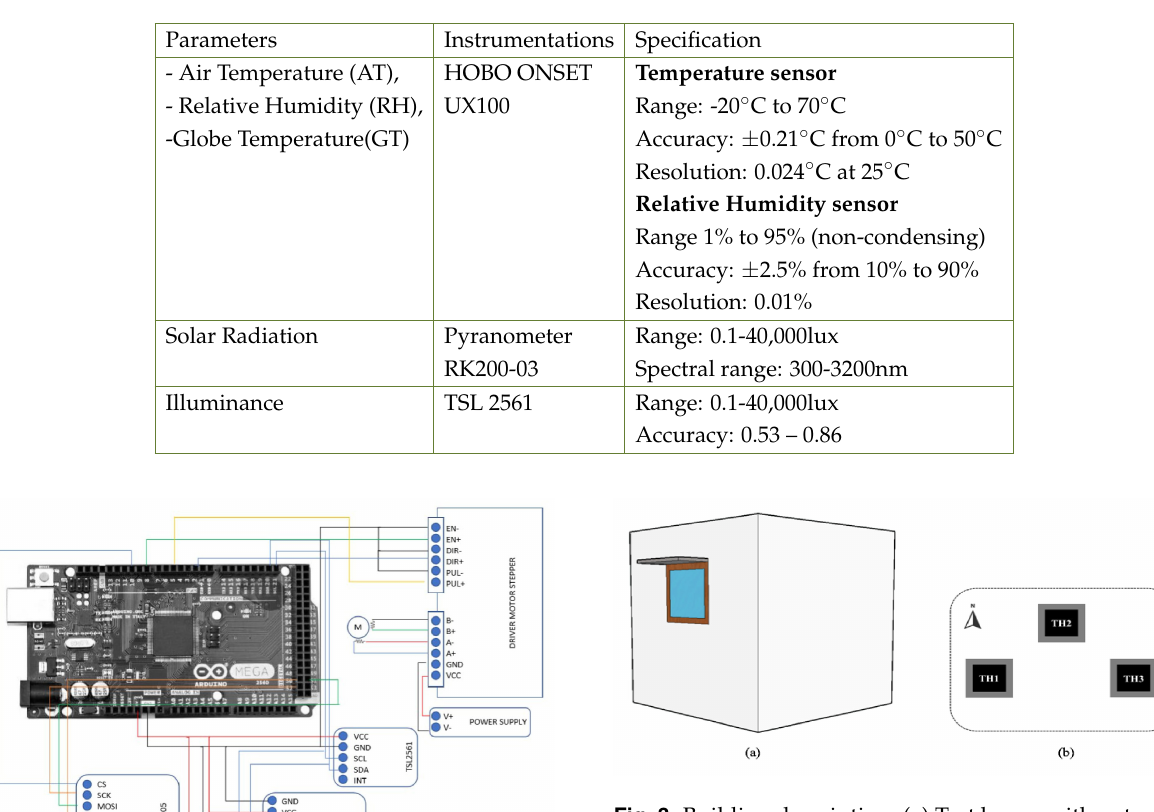
Fig. 3. Building description: (a) Test house with auto- mated shading; (b) Test houses